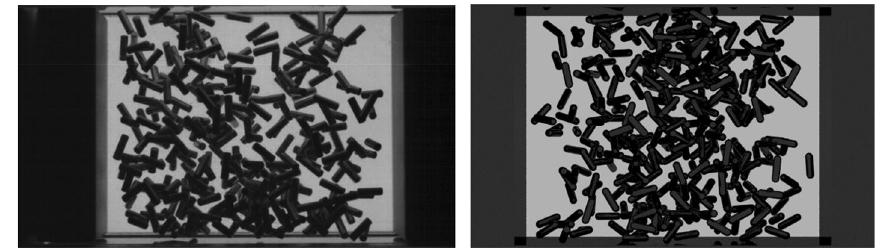
367 rods (filling fraction φ 2.0% ). Right: render = = 30 mm 2 . ×